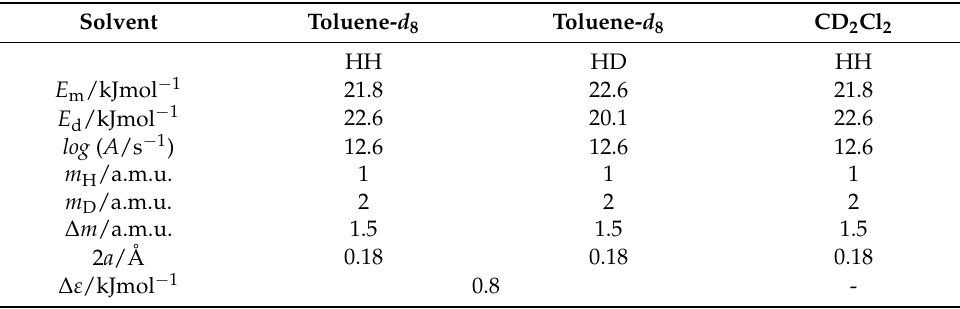
Table 5. Bell-Limbach tunneling model parameters of the tautomerism of TMRA.